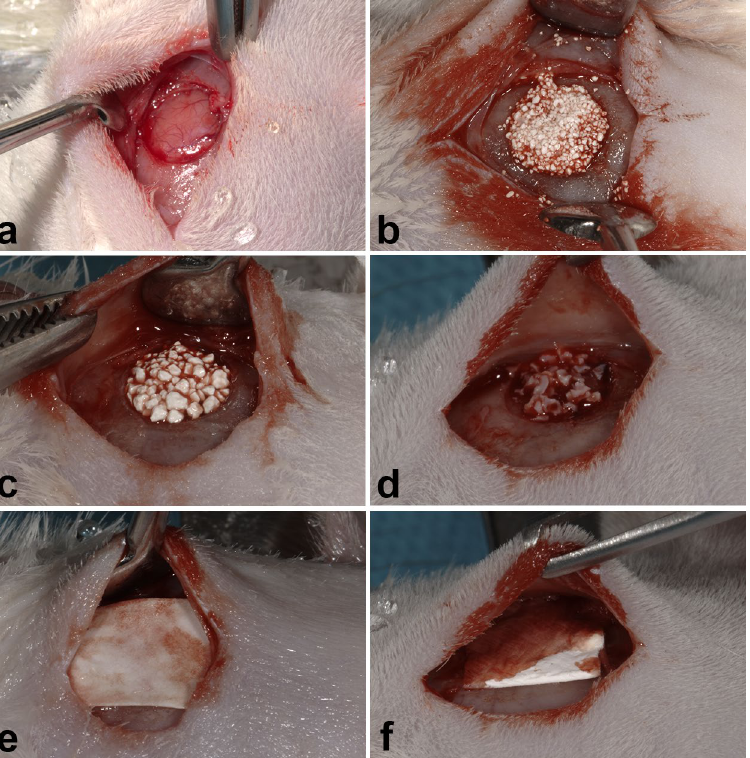
Figure 4. Images of surgical procedures. Dura mater exposure ( a ), defect filling with G1—Nanosynt 250 to 500 μm ( b ), G2—Nanosynt 500 to 1000 μm ( c ), G3—Bio-Oss 250 to 1000 μm ( d ), covered with Duosynt ( e ) and Bio-Gide membrane ( f